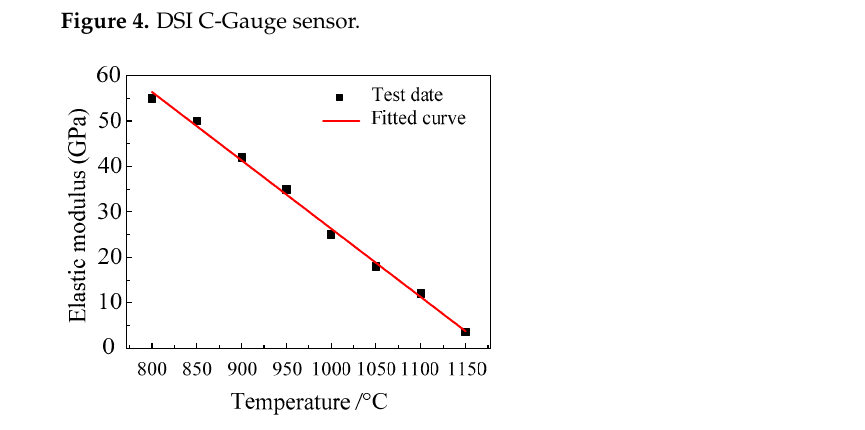
Figure 5. Fitting curve between the E value of the elastic modulus and temperature of the Cr5 alloy steel.